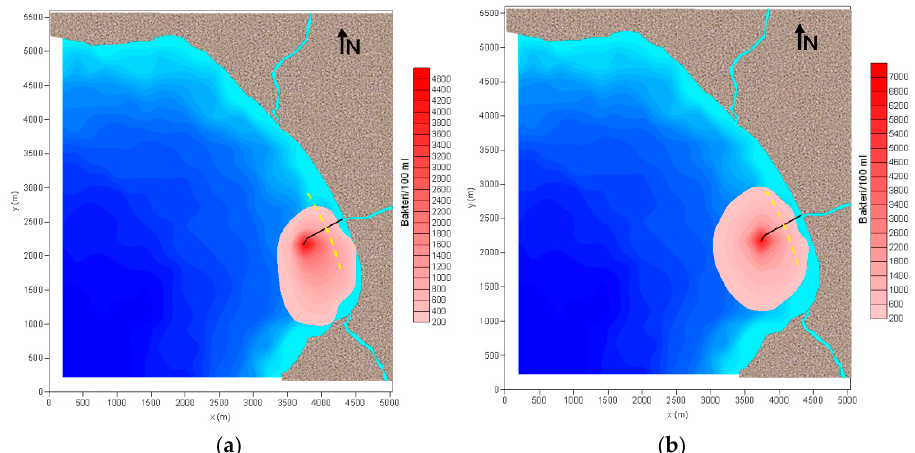
Figure 15. Distribution of the pollutant cloud caused by the wind blowing from WNW at: ( a ) 10 m/s and ( b ) 2 m/s [33].